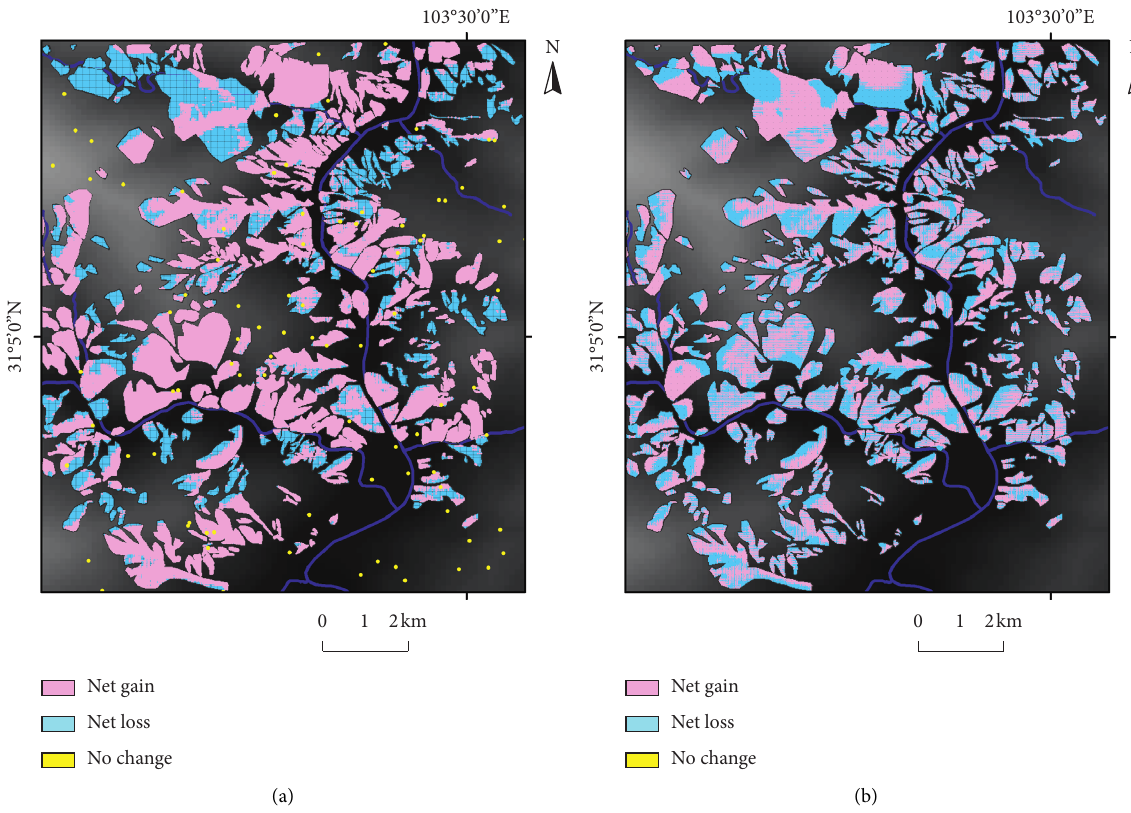
Figure 5: Difference between the pre- and postearthquake DEMs before the correction (a) and after correction (b) in the study area. Pink dots represent net gain, and blue dots represent net loss.